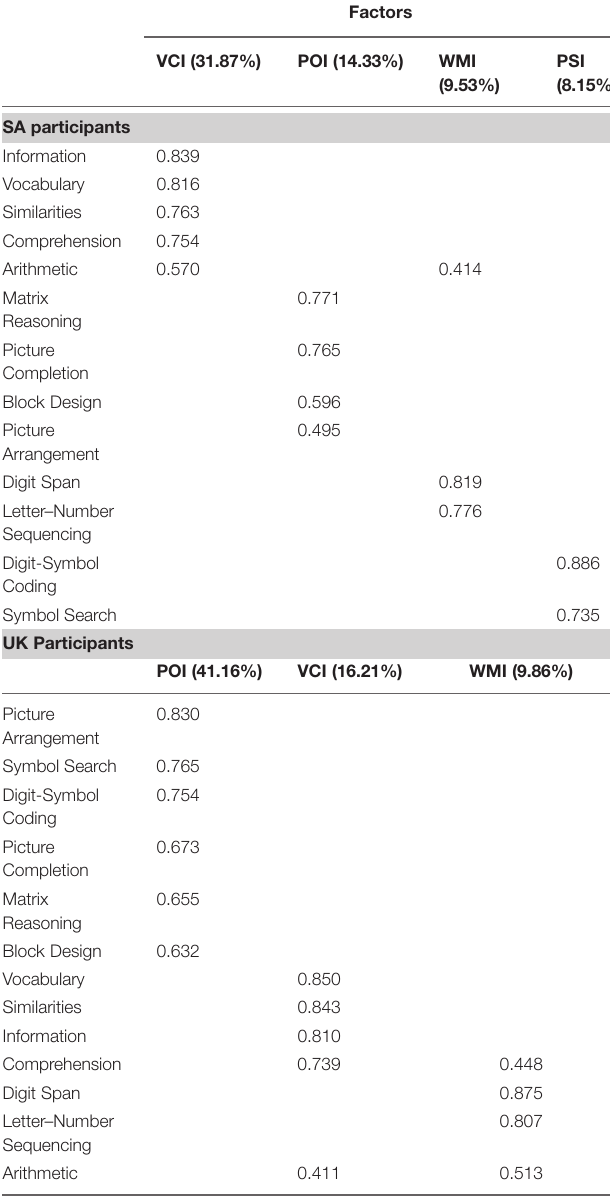
TABLE 4 | Principal components